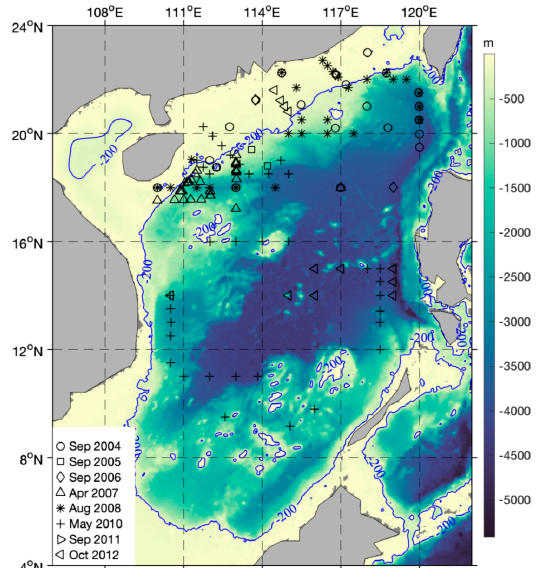
Figure 1. Hydrographic stations at which chlorophyll a (Chl-a) concentrations were measured in the South China Sea from 2004 to 2012. The survey stations from different cruises are distinguished by different marker types. The blue line shows the 200-m